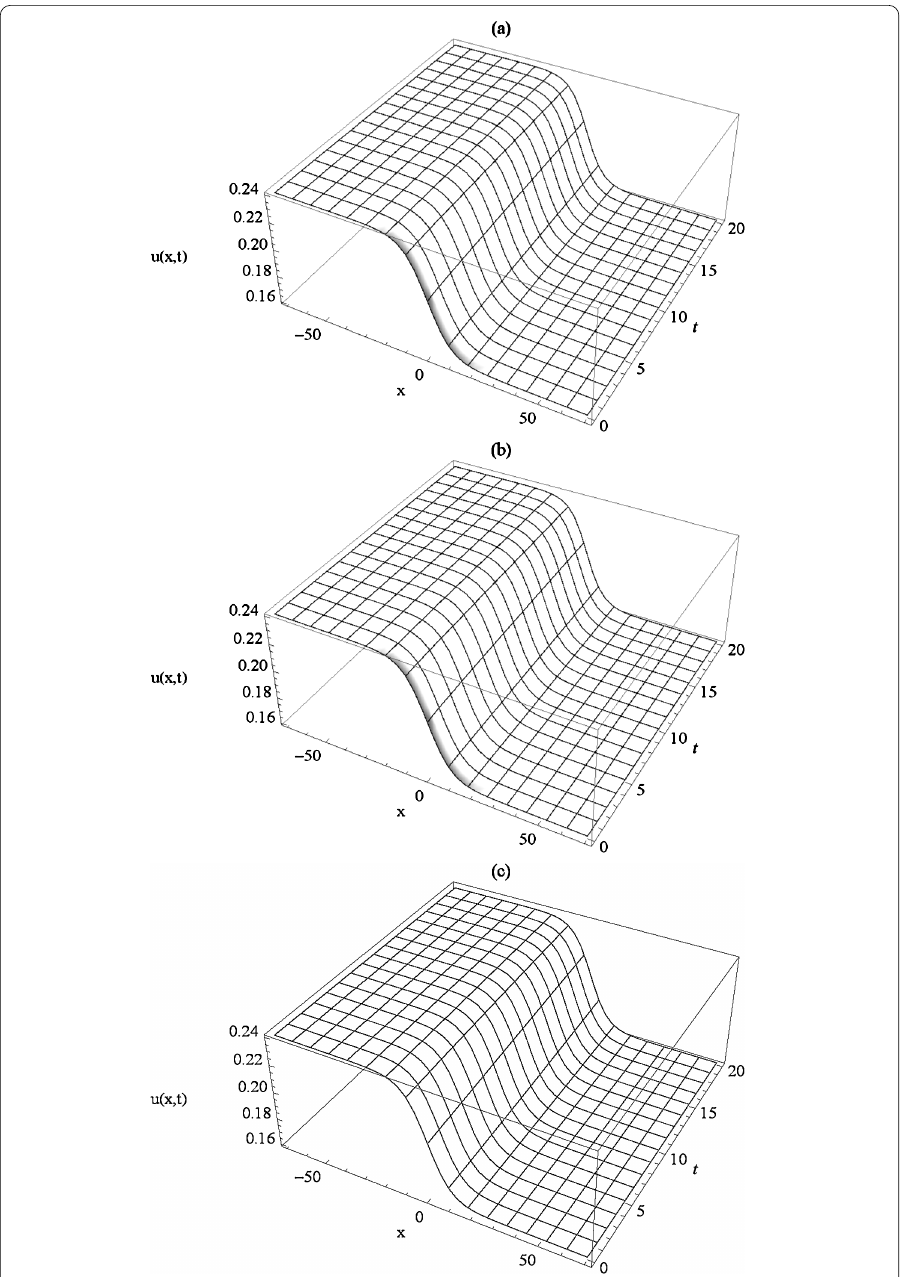
Figure 3 VIM solution (30) in the origin variable u for a = 1, b = 0.01 and c = 0.7 (a) α = 0.4, β = 0.6, (b) α = 0.6, β = 0.8, (c) α = 1, β = 1 and (d) combining